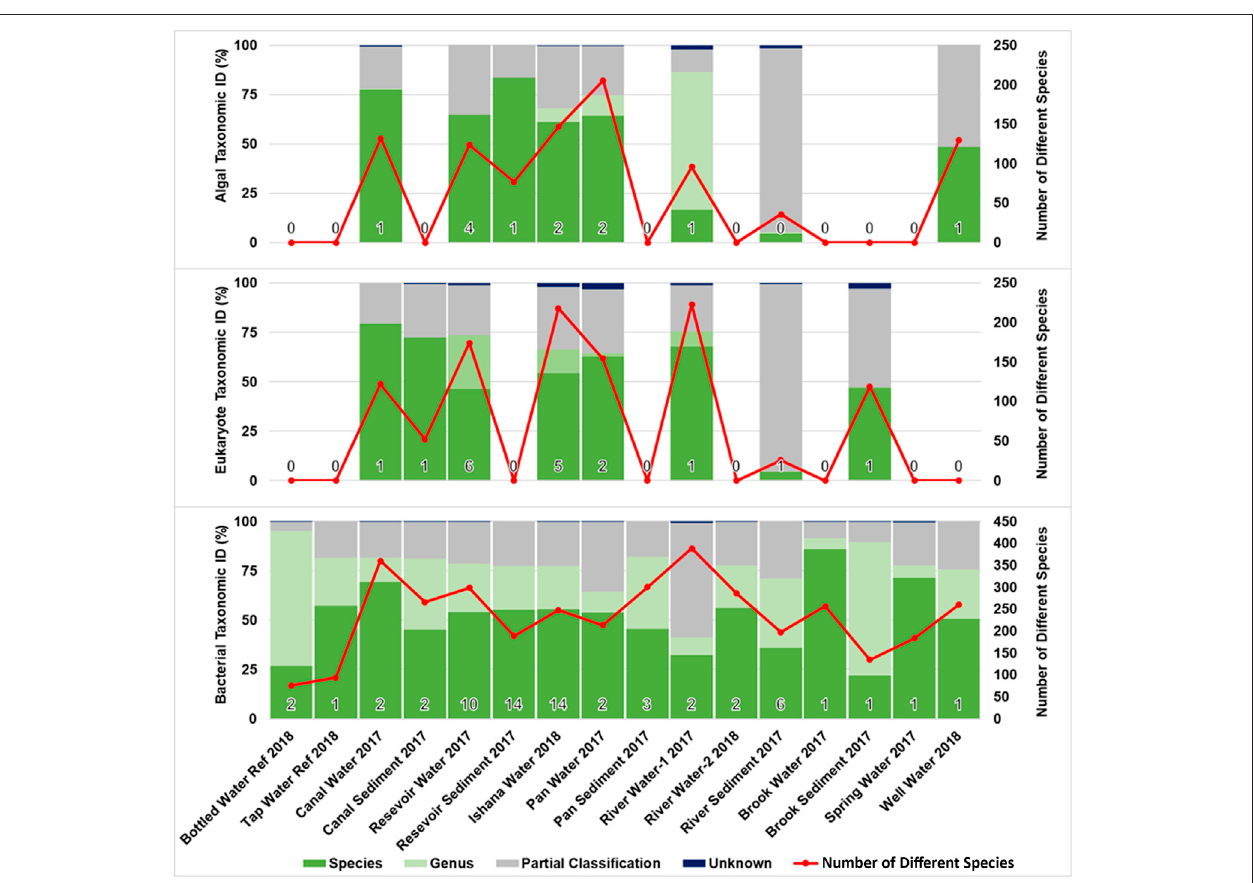
FIGURE3| Species identi fi cation and biodiversitypro fi les forenvironmenttypes. Thepercentage ofasamples ’ total reads taxonomicallyidenti fi edasbelongingto the Species, Genus or Partial Classi fi cation (at a higher taxonomic level than species or genus) groupings, expressed as percentage compositions. The Number of Different Species taxonomically identi fi ed for each sample is shown; indicating the complexity of sample composition. For each sample, a number (bottom of each bar) indicates the number of ampli fi ed samples averaged for each environment type (for Algal (RBCL), Eukaryote (COI) and Bacterial (16s) primers).